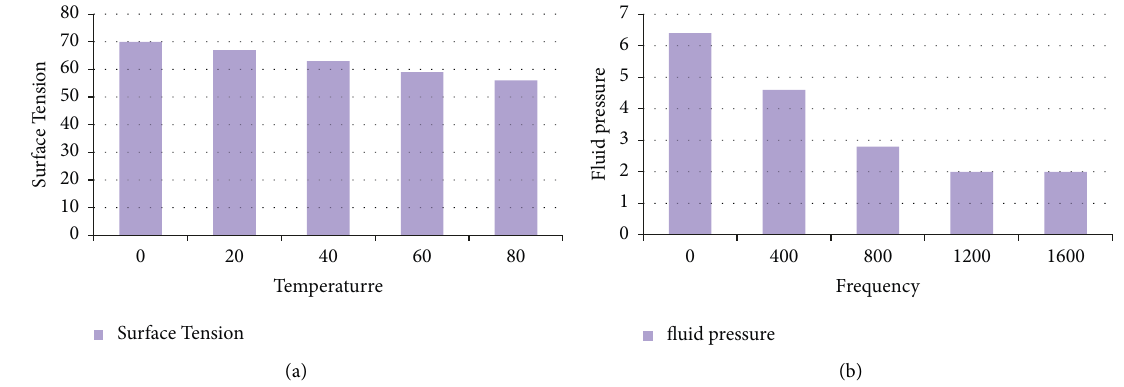
Figure 6: The effect of temperature changes and the effect of ultrasonic frequency changes.